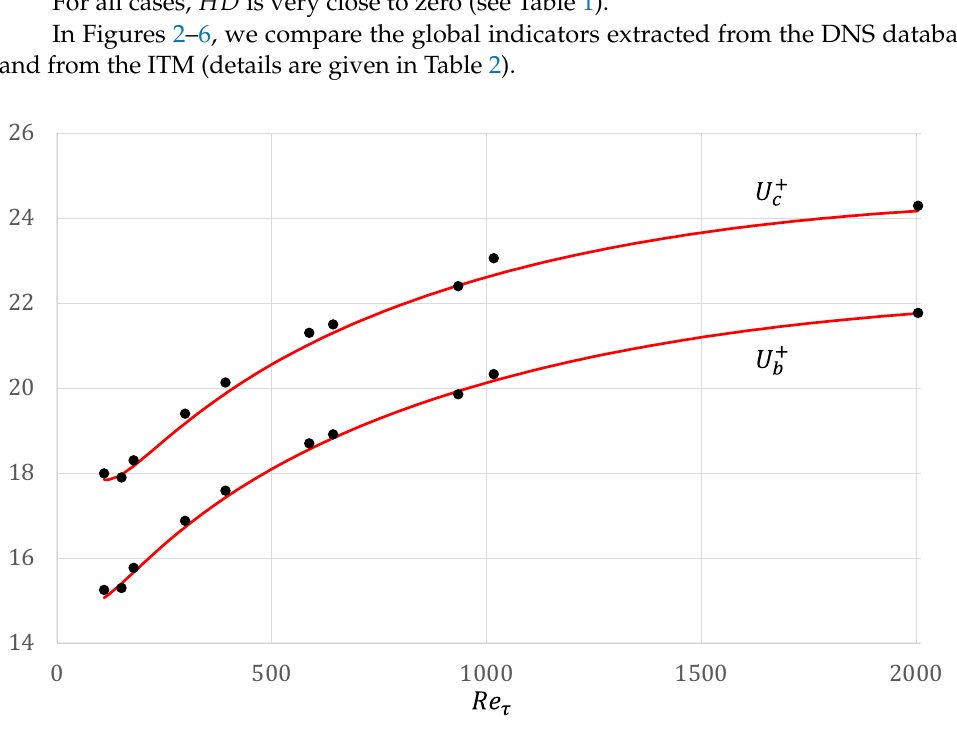
; • DNS data; and ─ ITM. 𝑐𝑐+ 𝑏𝑏+ ⁄ 𝑈𝑈 𝑈𝑈